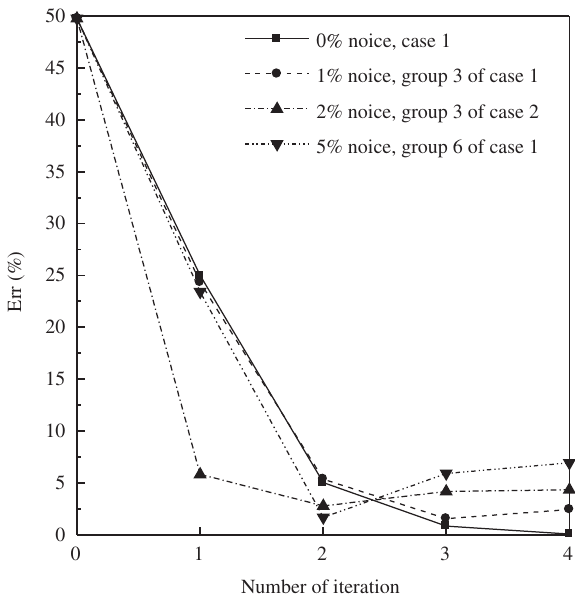
Figure 6: Convergence rate in the identification process of a square FGM plane structure with exponential material variation.